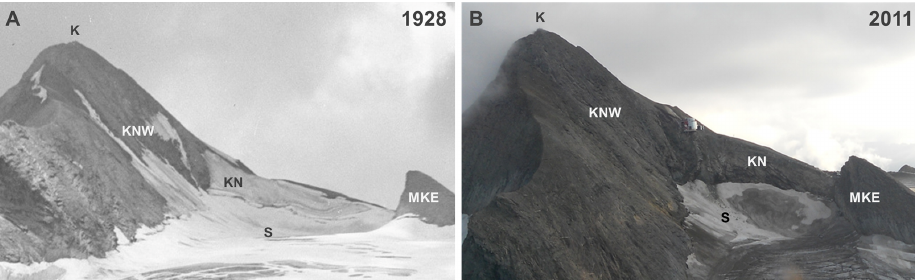
Figure 4. View of Kitzsteinhorn (K) (3203ma . s . l . ) and Schmiedingerkees (S): (a) September 1928 (photo: Stadtarchiv Salzburg, Fotosamm- lung Josef Kettenhuemer); (b) September 2011 (photo: Heinz Kugler). During the reference period, the ice surface has lowered considerably, while all ice aprons have completely disappeared. Much of the surface change has occurred since the 1980s (Slupetzky, 2015). Abbreviations: K is the Kitzsteinhorn summit, KN is the Kitzsteinhorn north face, KNW is the Kitzsteinhorn northwest face, MKE is the Magnetkoepfl east face, and S is the